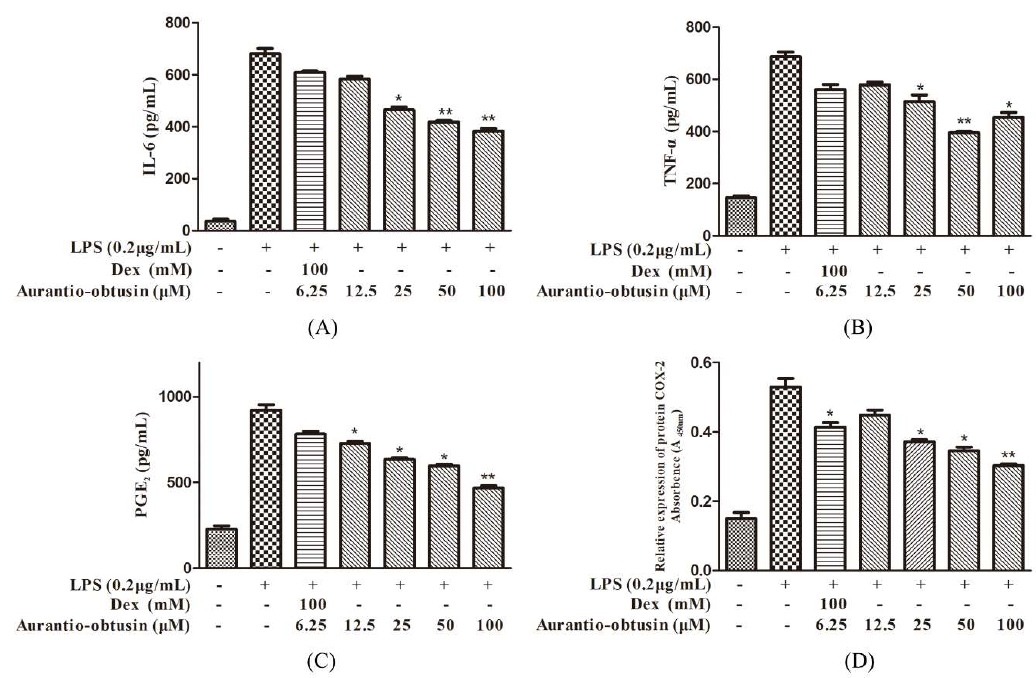
Figure 4. Effect of aurantio-obtusin on IL-6, TNF- α , PGE 2 production and COX-2 protein expression in LPS-treated RAW264.7 cells. The cells were treated with various concentrations of aurantio-obtusin (6.25–50 µ M) for 2 h, followed by stimulation with LPS (0.2 µ g/mL) for 24 h. IL-6 ( A ), TNF- α ( B ) and PGE 2 ( C ) production in the culture medium was determined by ELISA, and the COX-2 protein expression ( D ) analyzed by cell-based ELISA. The data are presented as mean ± SD ( n = 3). * p < 0.05 and ** p < 0.01 represent significance when compared to LPS-only treated cells.